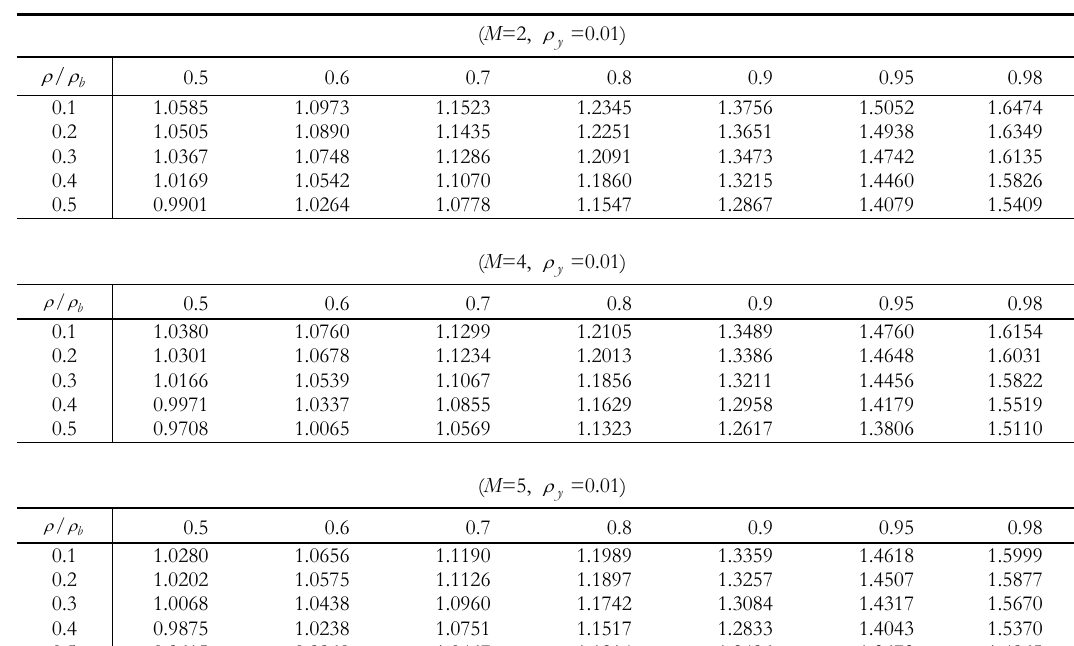
Relative efficiency of cluster sampling over simple random